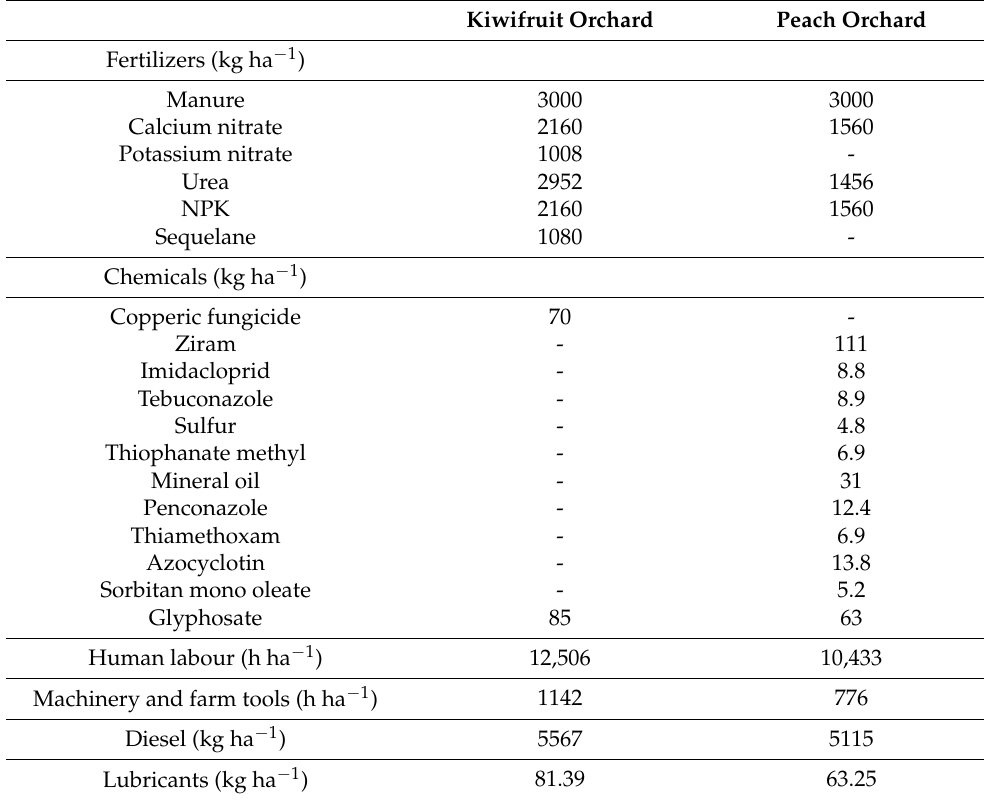
Table 2. Farm inputs used in the examined fruit orchard systems during the whole production cycle (20 and 15 years for kiwifruit and peach orchards, respectively). Kiwifruit Orchard Peach